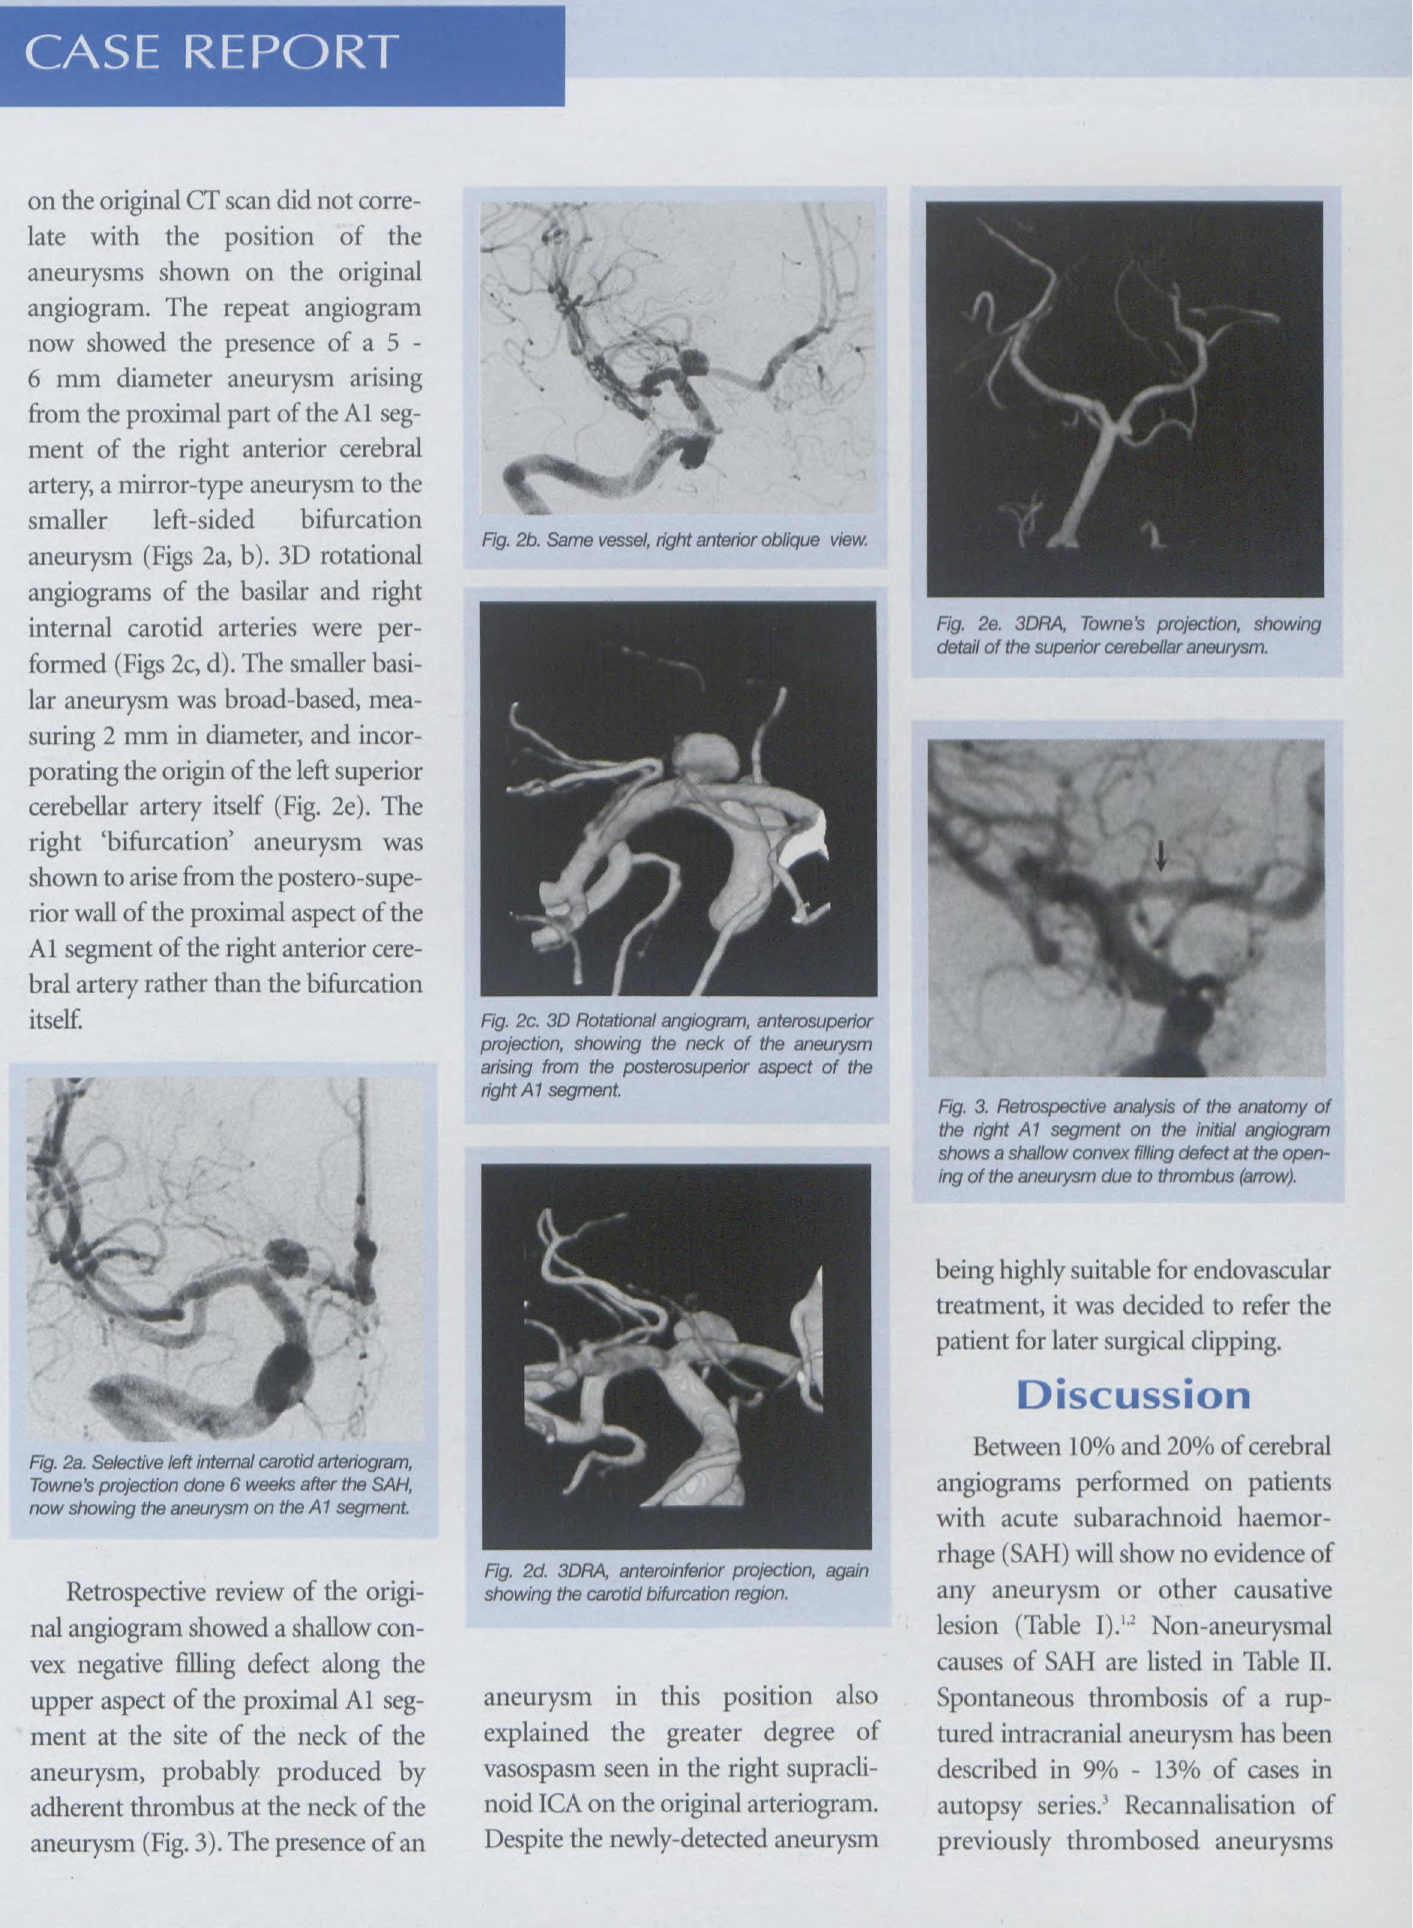
aneurysm ill this